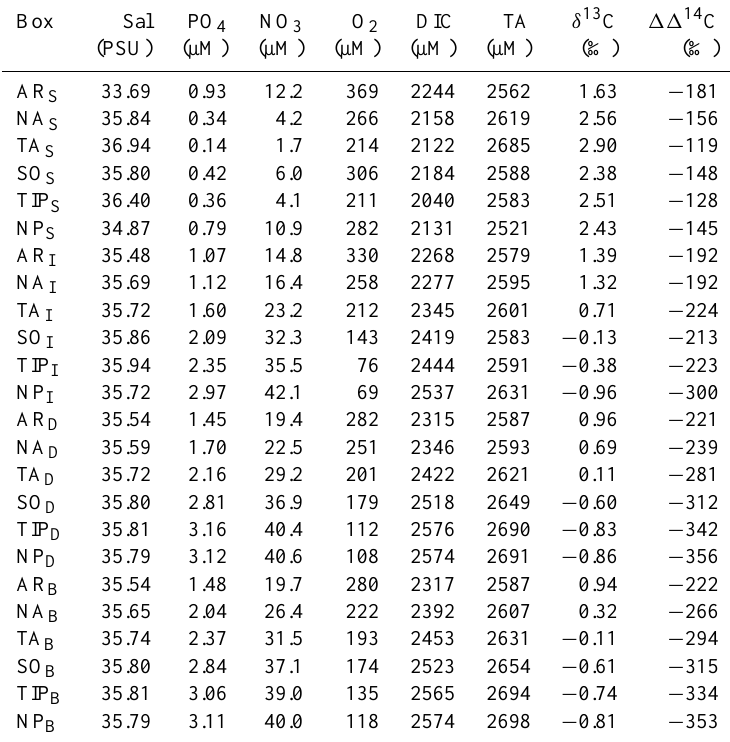
Table C4. LGM tracer concentrations in model boxes at 21ka in simulation STD (see Tables A1 and A2 for further